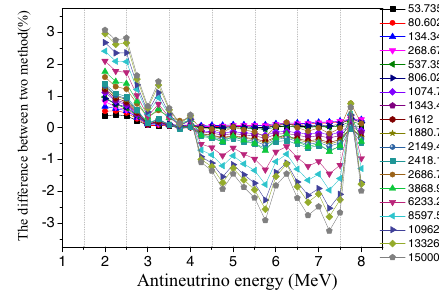
Figure 5. ∆ S ( E ν , t ) as a function of antineutrino energy Comparing with the measured antineutrino spectrum in Daya Bay, it is found that the neutrino energy